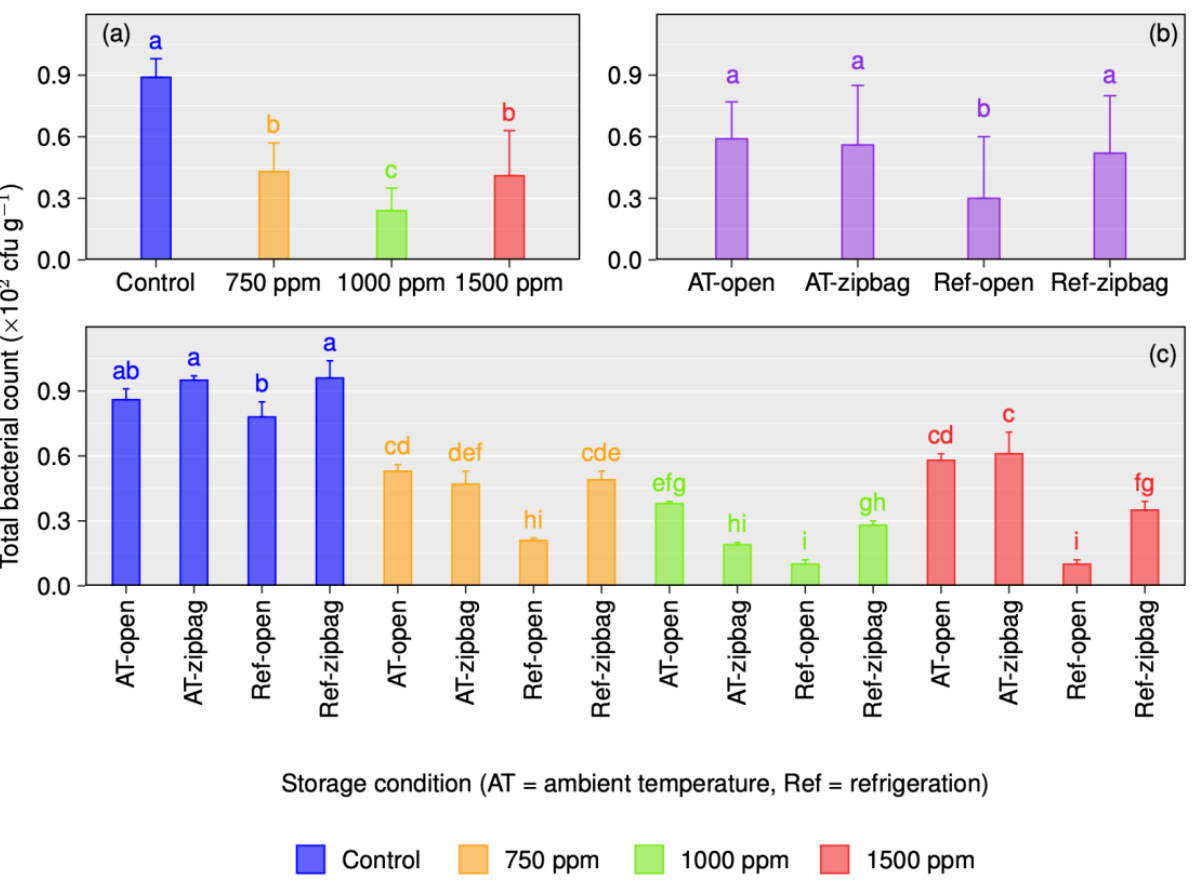
Figure 3. Total bacteria count (TBC) of different concentration of chitosan-treated and untreated Gopal vogh mango stored in the open or in zip-bags at ambient temperature and refrigeration temperature ( a – c ). Means with the same letters are not statistically different from each other as per Tukey’s post hoc test ( p = 0.05).